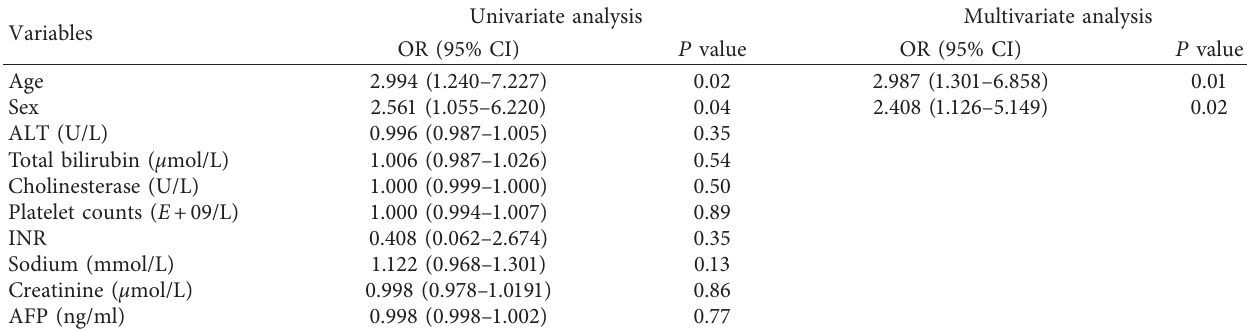
Table 2: Risk factors for HCC development in patients with hepatitis B virus-related decompensated cirrhosis.